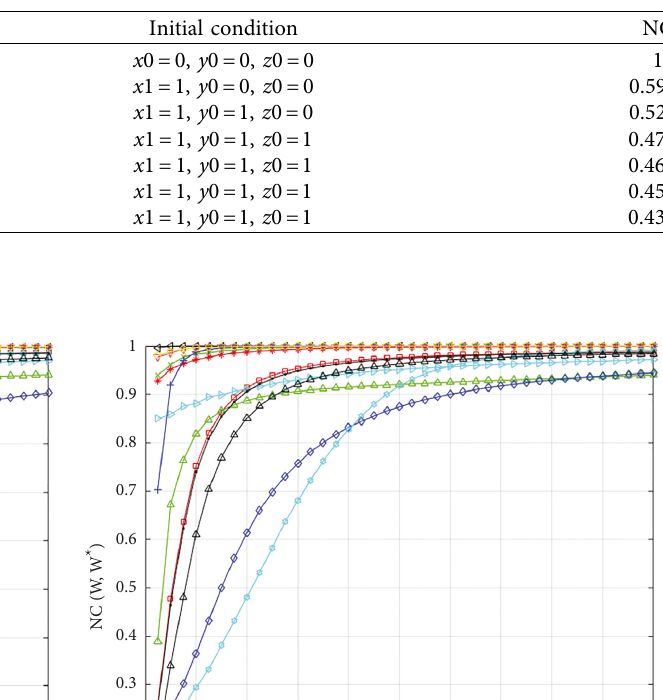
Table 3: FPP analysis result.